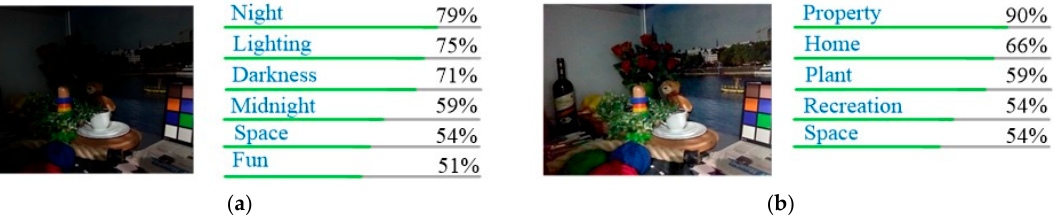
Figure 12. Results of Google Cloud Vision API for “Room” from LIME dataset. ( a ) Recognizing result